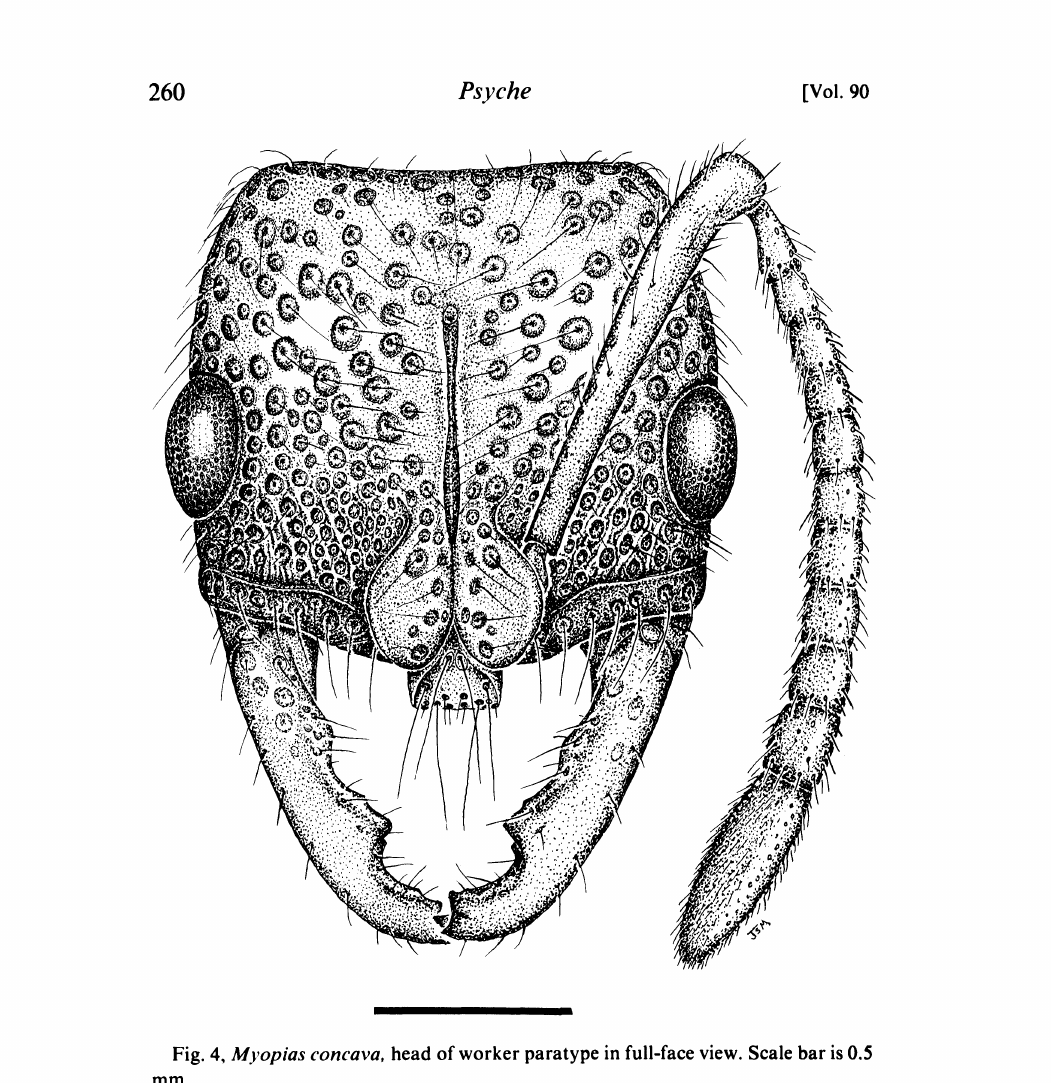
Fig. 4, Myopias concava, head of worker paratype in full-face view. Scale bar is 0.5